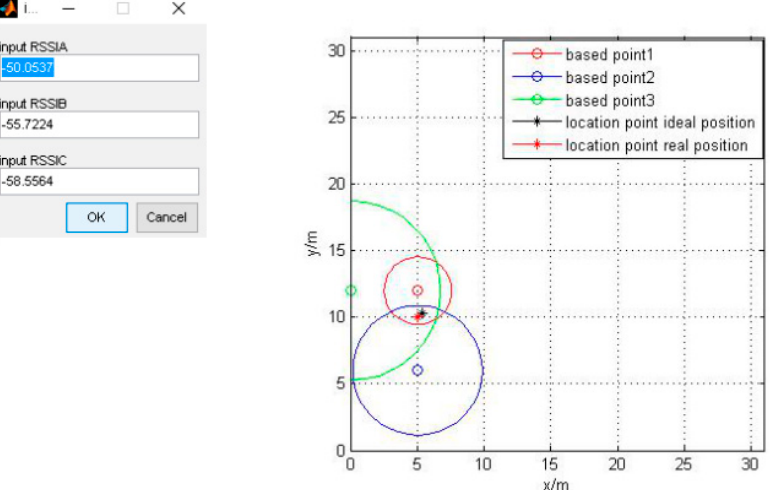
Figure 5. Simulation result when the RSSI values are − 50.0537, − 55.7224, and − 58.5564 (dBm) for the three points (a, b, and c).